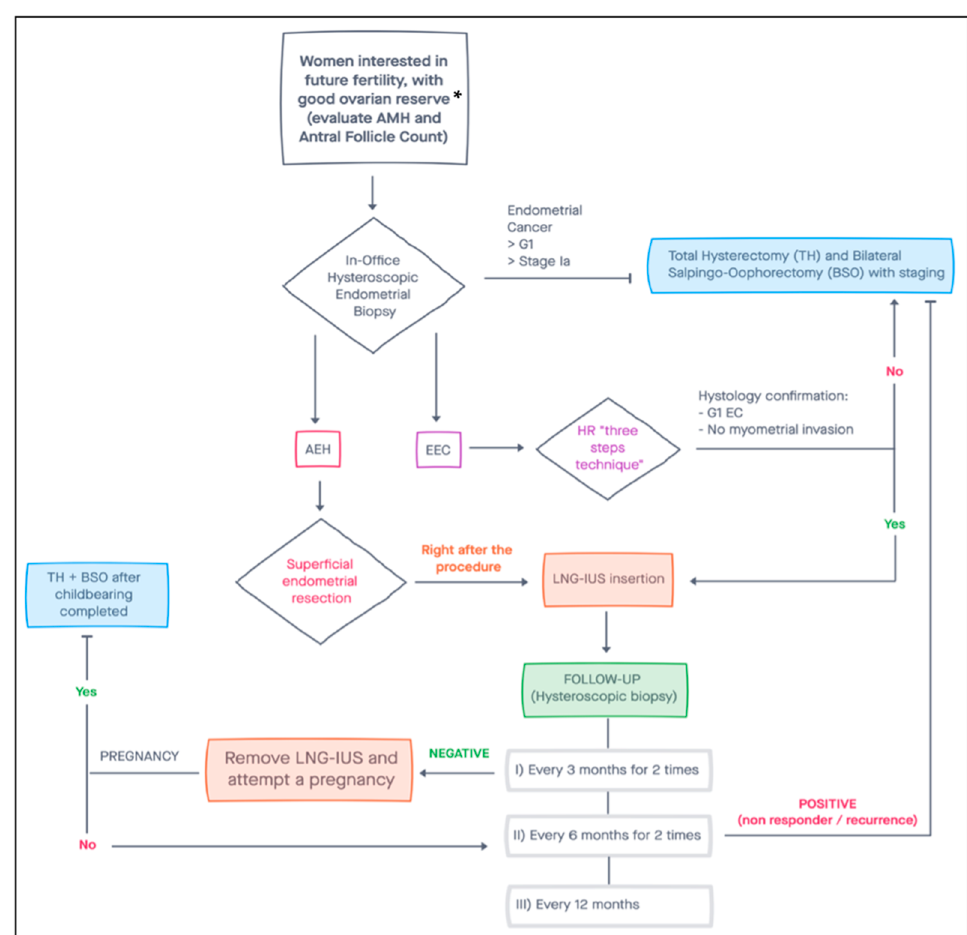
Figure 1. Suggested flow-chart for conservative management of women with endometrial cancer. * Patients with a diminished ovarian reserve may still benefit from fertility-sparing surgery, attempting a pregnancy with heterologous oocytes. AMH, Anti-Müllerian Hormone; AEH, Atypical Endometrial Hyperplasia; EEC, Early Endometrial Carcinoma; EC, Endometrial Cancer; HR, Hysteroscopic Resection; LNG-IUS, Levonorgestrel Intrauterine System.